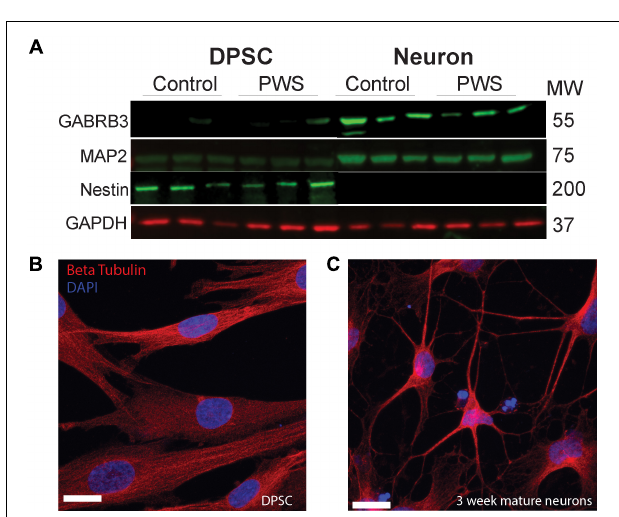
FIGURE 2 | DPSC from both PWS and control subjects differentiate efficiently into neuronal cultures. (A) DPSC from all subjects are negative for neuronal markers, MAP2 and GABA A, but positive for stem cell marker NESTIN. After differentiation and 3 weeks of maturation, the cultures are positive for both MAP2 and GABA A receptor subunit beta 3. (B,C) Representative DPSC versus DPSC-derived neurons visualized with anti-beta tubulin (red) (B) DPSC show a flat fibroblast-like morphology as previously reported. (C) DPSC-derived neuronal culture contains cells with pyramidal neuron morphology. DAPI (blue) was used as a nuclear stain. 63 × magnification. Scale bar is 20 µ